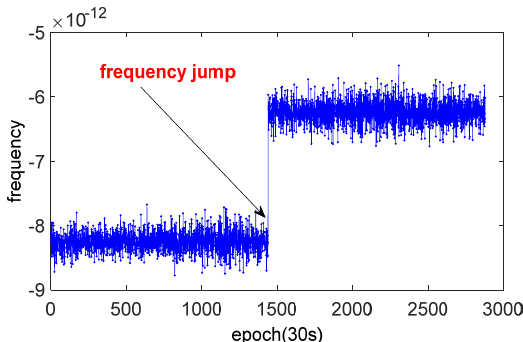
Figure 2. Frequency jump of satellite clock.